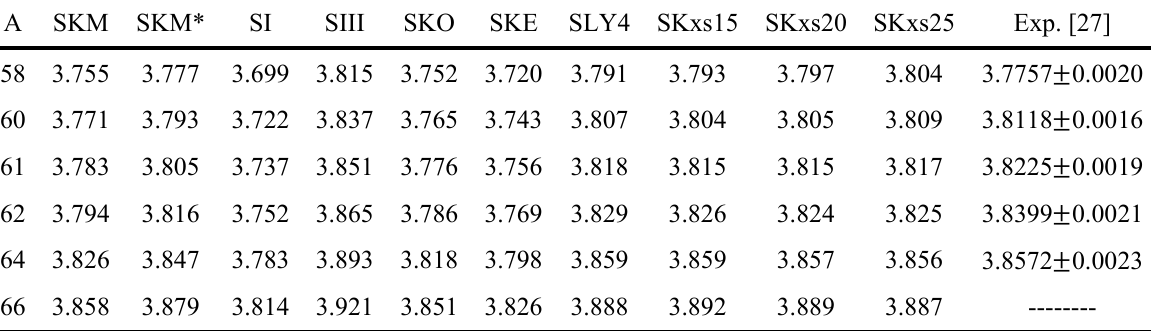
Table 2: Calculated charge rms radii (fm) using different Skyrme parameterizations in comparison with experimental data.